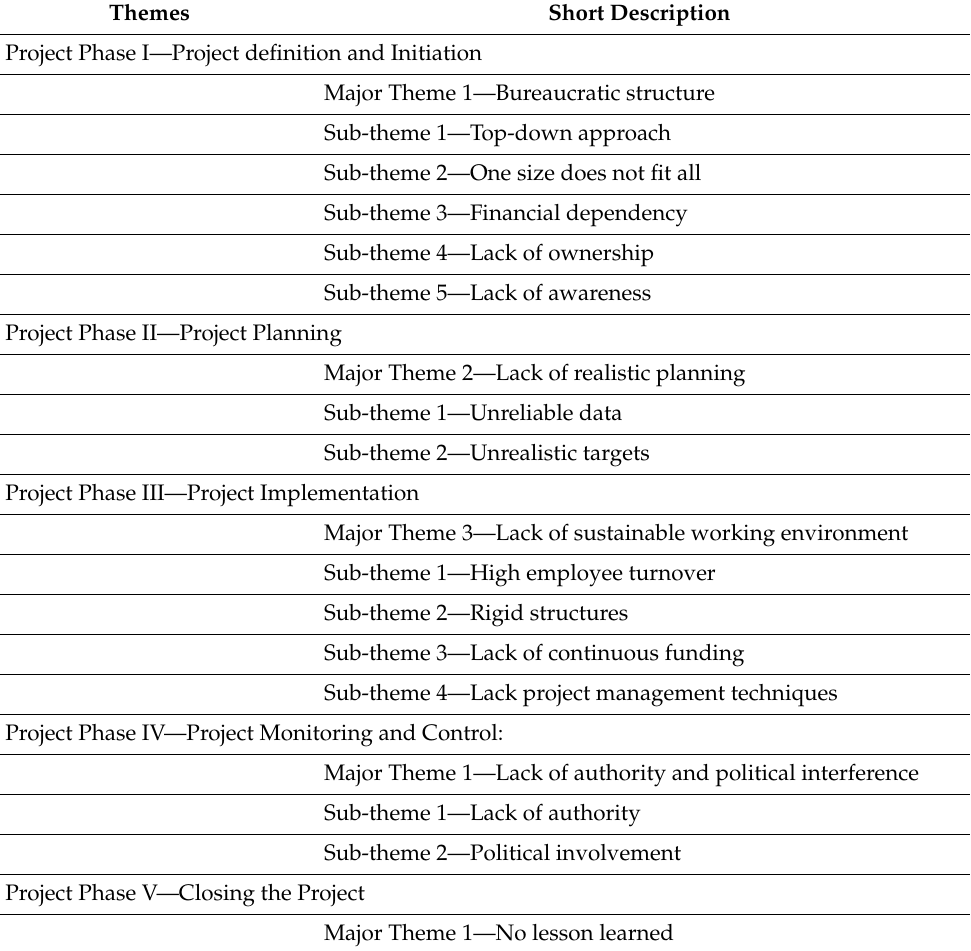
Table 2. Themes and